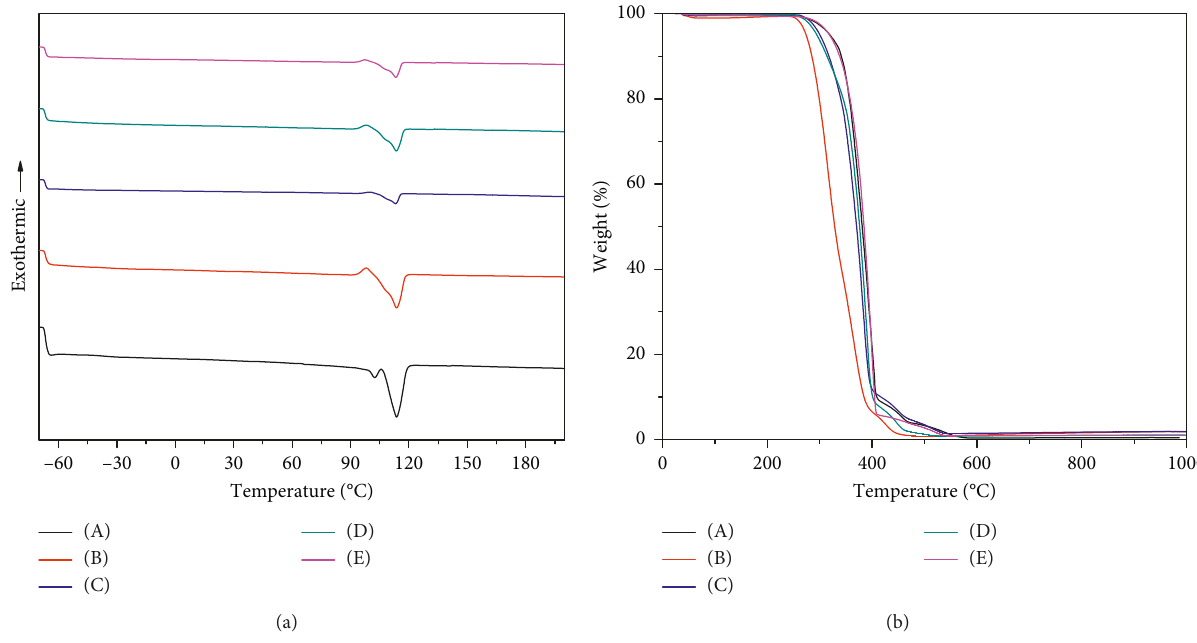
Figure 10: (a) DSC and (b) TGA thermograms of the pristine PBS and the AgCB-PBS composite materials. Note that the labels shown in the plots represent the materials as follows: (A) PBS, (B) 3AgCB-PBS, (C) 5AgCB-PBS, (D) 10AgCB-PBS, and (E)